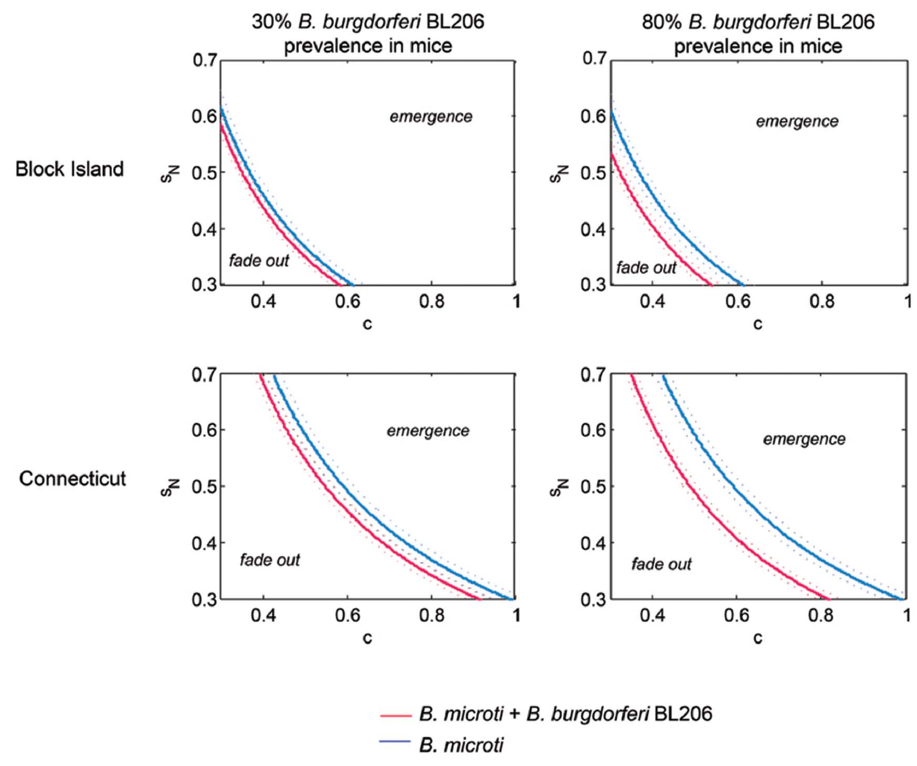
Fig 5. Threshold curves for Babesia microti survival at different locations and mouse infection prevalences with Borrelia burgdorferi strain BL206. This figure shows differences in threshold curves, representing where R 0 5 1, and associated 95% confidence intervals (dotted curves), that separate regions of s N and c where B. microti is expected to emerge and regions where it is expected to fade out. Threshold curves are contour curves where R 0 is plotted as a function of two variables: the proportion of fed infected larvae that survive to become infectious feeding nymphs, s N , and the proportion of ticks feeding on Peromyscus leucopus , c. Plots indicate effects of location specific (Block Island and Connecticut) timing of tick activity as well as B. burgdorferi strain BL206 strain prevalence in mice (low 5 0.3 and high 5 0.8) on R 0 . Coinfection significantly enhances the likelihood of B. microti establishment in Connecticut and on Block Island when B. burgdorferi prevalence among P. leucopus is high (0.80) (confidence bounds do not overlap). Differences in threshold curves for B. burgdorferi strain B348 are shown in S3